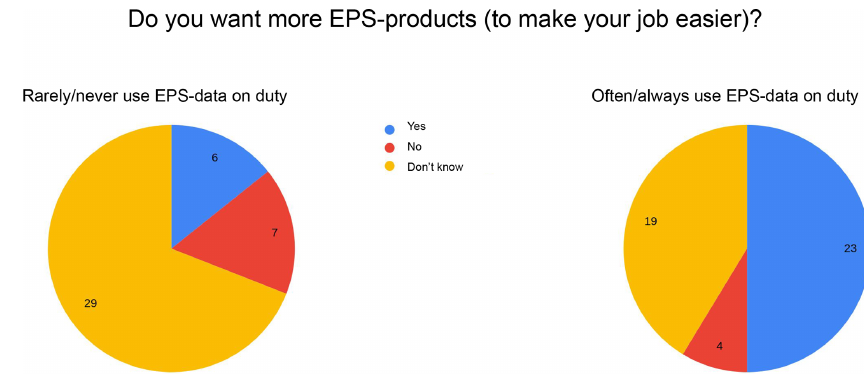
Figure 4. 88 operational forecasters at MET Norway answered this question in the survey. In the analysis, we compared the answers from the forecasters that rarely use EPS-data on duty with them that normally use such data. It looks that if you are used to using EPS, you are also more open to new